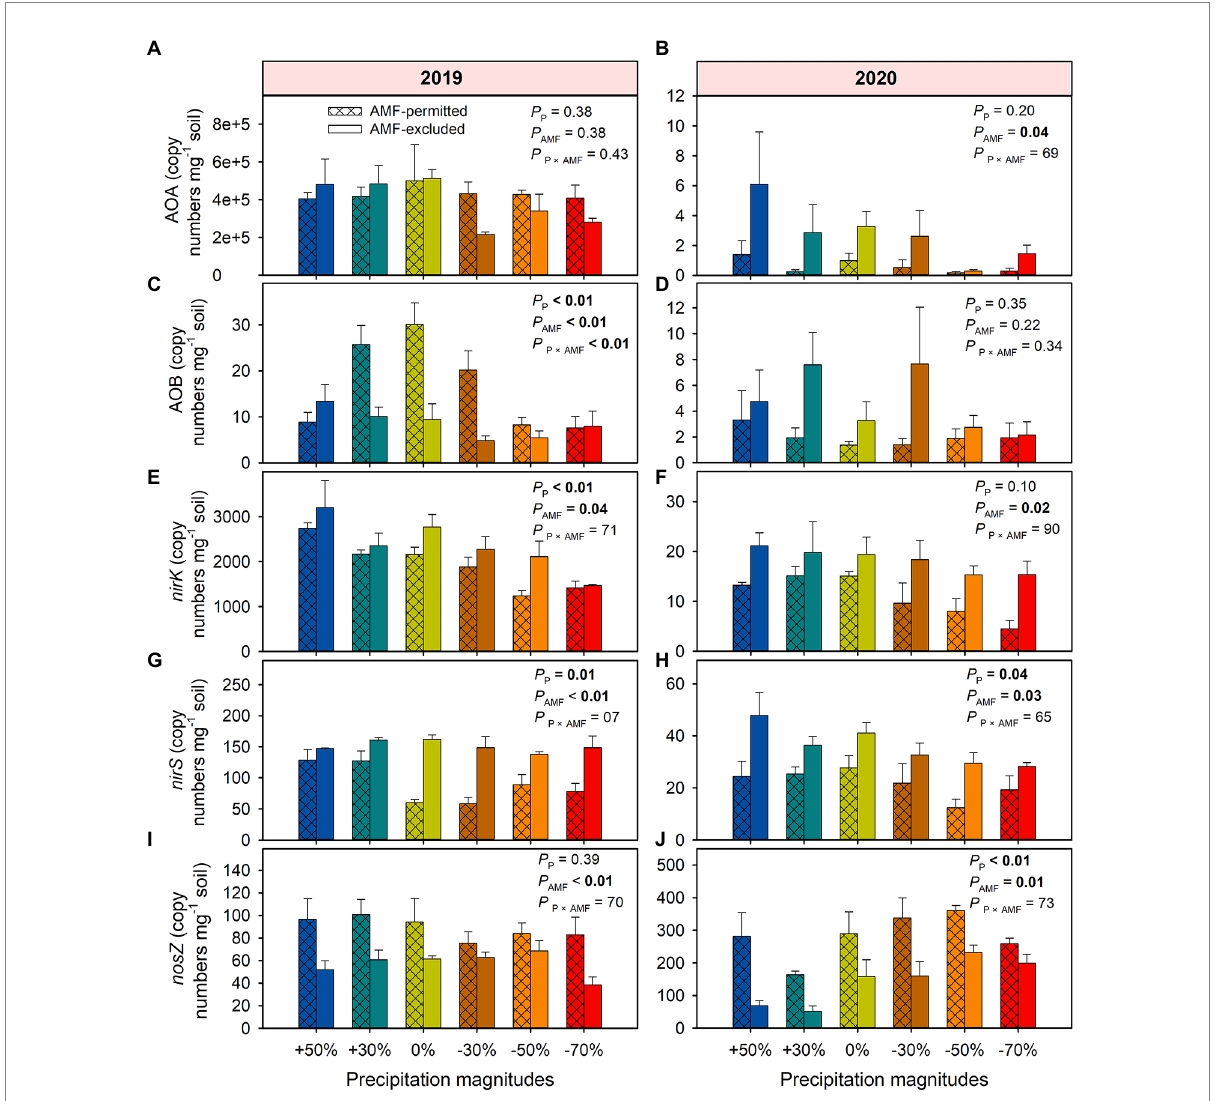
FIGURE 5 The effects of precipitation and AMF on functional gene copy numbers in 2019 (A,C,E,G,I) and 2020 (B,D,F,H,J) . The values in boldface type denote significant differences between treatments ( p < 0.05). Data are reported as mean ± 1 SE ( n =